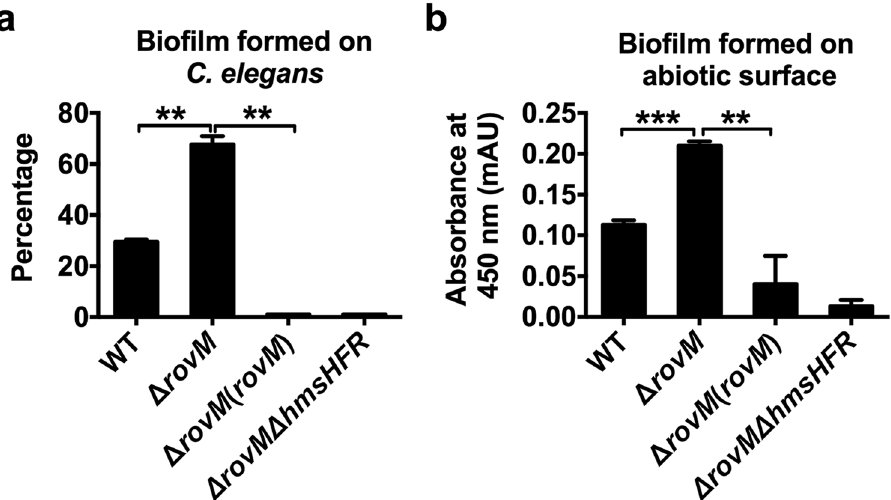
Figure 4. RovM represses biofilm formation. ( a ) Biofilm severity as a measurement of biofilm formation on C. elegans by wild-type strain, Δ rovM , Δ rovM ( rovM ) and Δ rovM Δ hmsHFR . ( b ) Biofilm formed on abiotic surface (in 96-well plates) by the indicated strains. Data shown are the average of three independent experiments; error bars indicate SD from three independent experiments. * P < 0.05; ** P < 0.01; *** P <